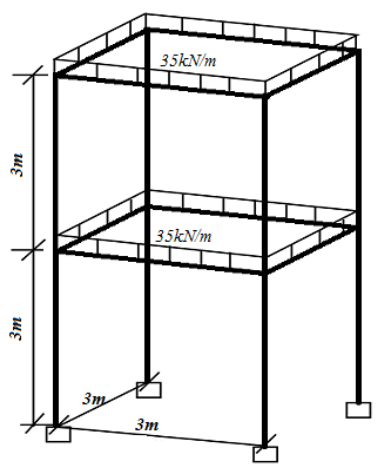
Figure 7. The 3-D frame and loading